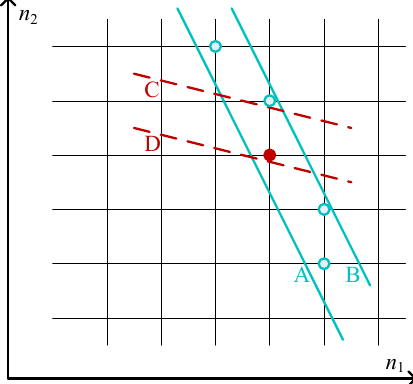
Figure 3. Two-dimensional case of the traditional congestion game (TCG) for the proof of Theorem